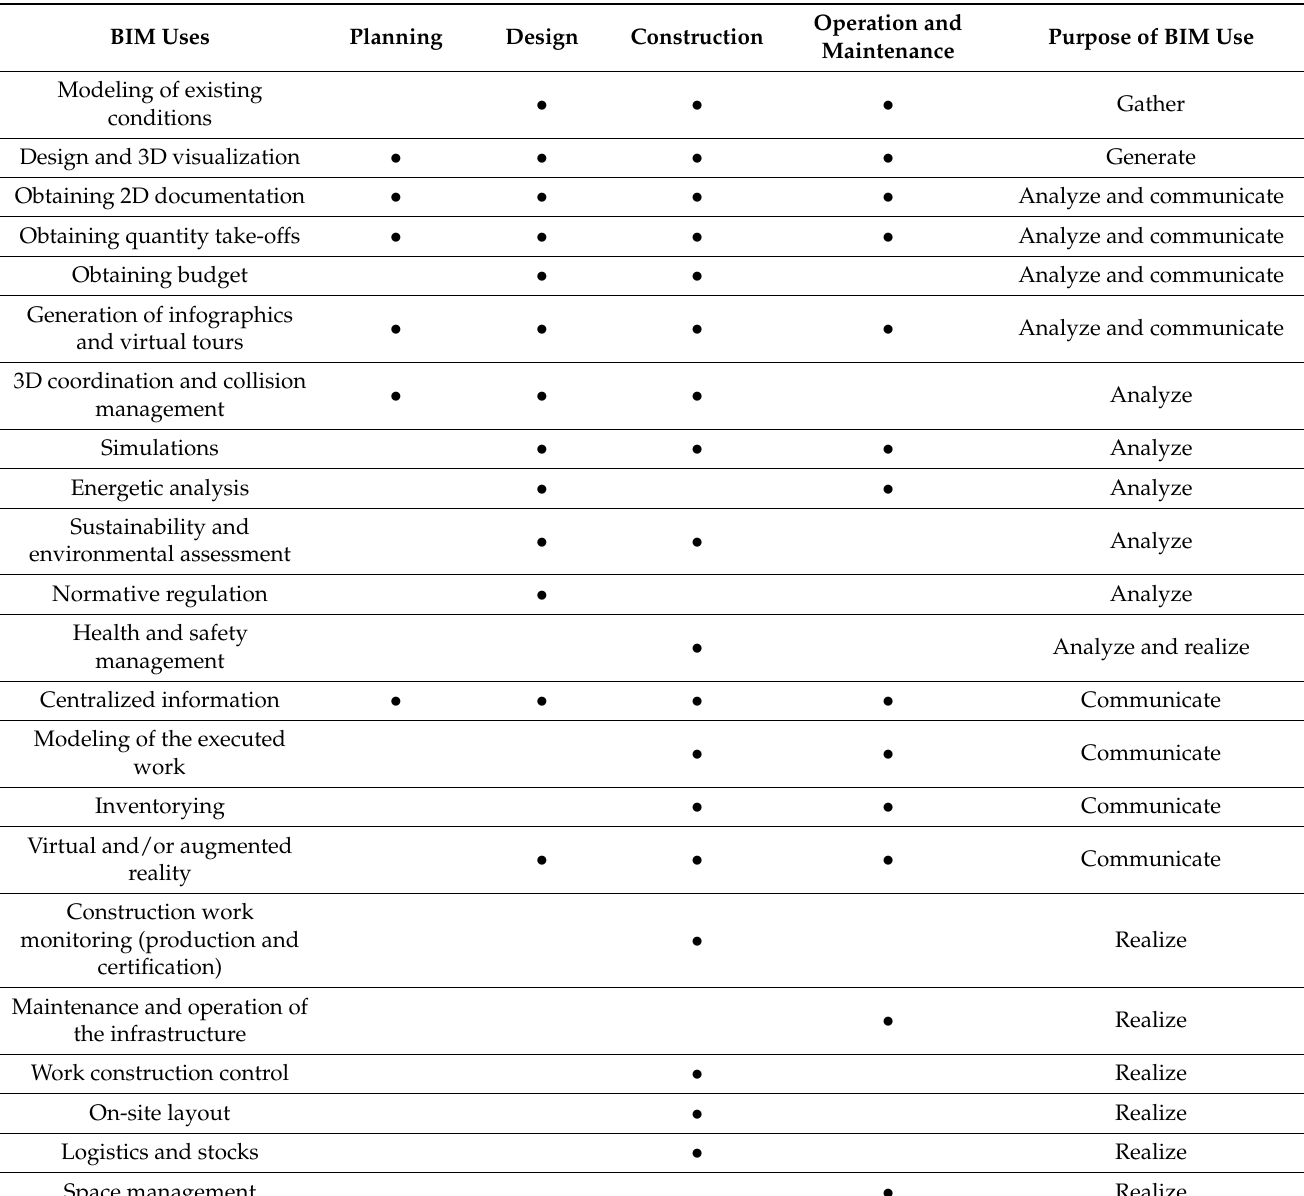
Table 1. Proposed BIM uses for inclusion in public sector